Question: Does the figure show an increasing or a decreasing trend?
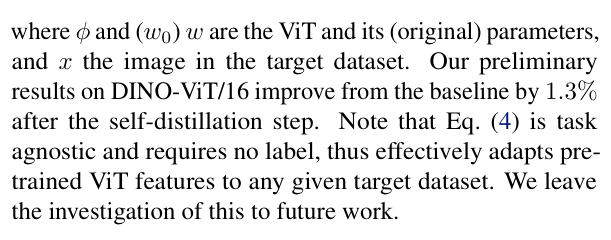
Answer: increasing